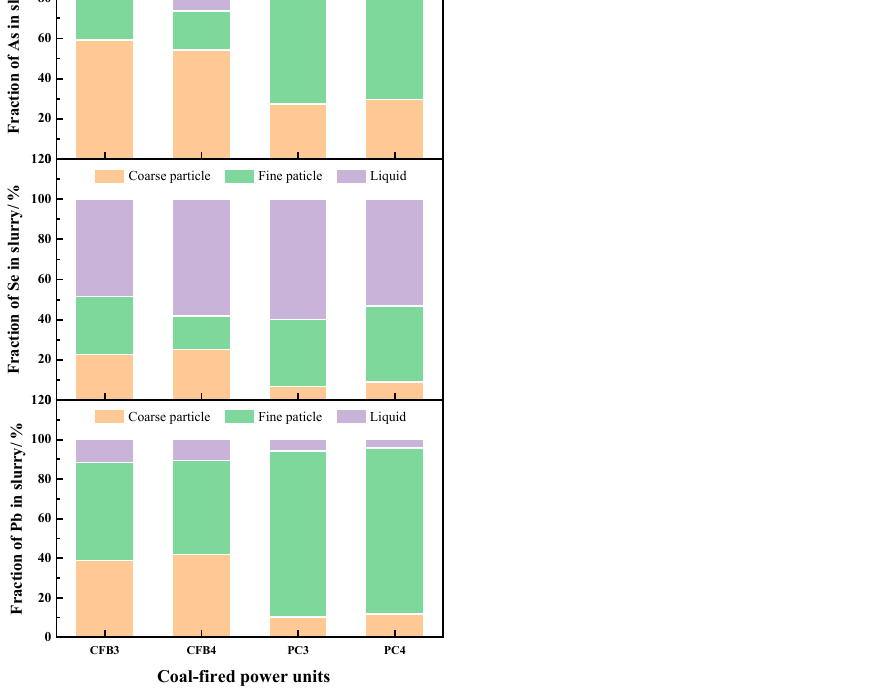
Figure 5. Partitioning of As, Se and Pb in coarse particles, fine particles and liquid fraction of WFGD slurry.